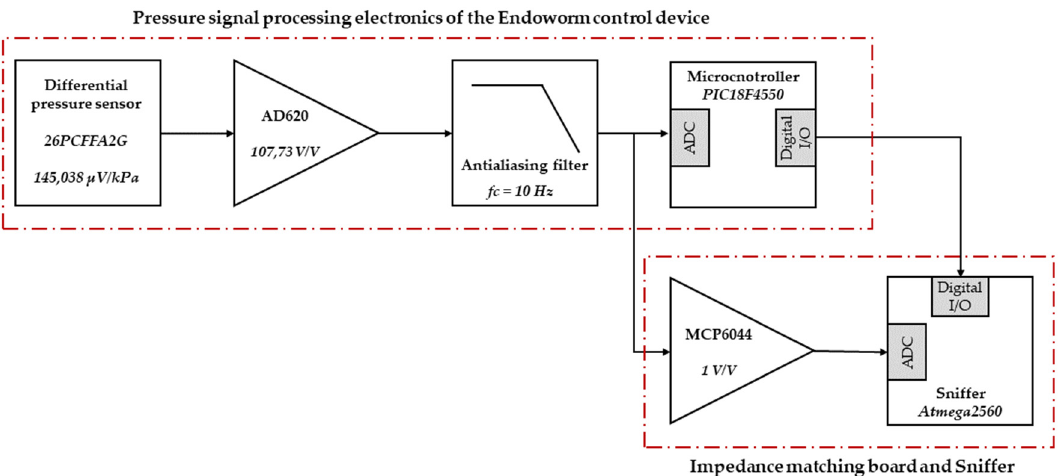
Figure 1. Diagram of the circuit for adapting the 26PCFFA2G sensor output signal to the ADC input of the Endoworm microcontroller ( PIC18F4550 ), as well as the capture of the pressure signals, through the impedance matching board, and the main digital control signals.